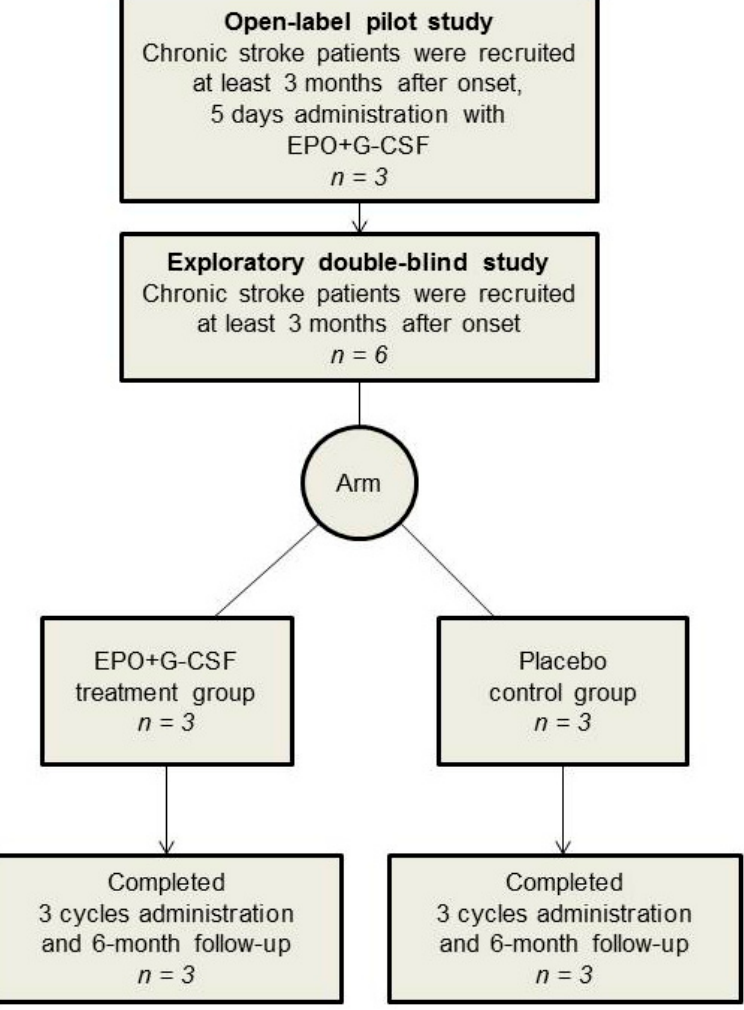
Figure 1. Flow of participants through the study. For a pilot study, three patients with chronic stroke were treated with subcutaneous recombinant human EPO (300 U/kg) and recombinant human G-CSF (10 µ g/kg) once a day for 5 consecutive days with follow up on day 30. Six patients with chronic stroke were randomly allocated into two groups (3 EPO+G-CSF and 3 placebo) in an exploratory double-blind study. The EPO+G-CSF arm was administered as the same treatment as the pilot study per cycle (one month) over a total of 3 cycles. The placebo arm had the same schedule of subcutaneous saline injections as the treatment arm. After completing three treatment cycles, participants in the double-blind study received follow-up for six months from the start of combination therapy in the same